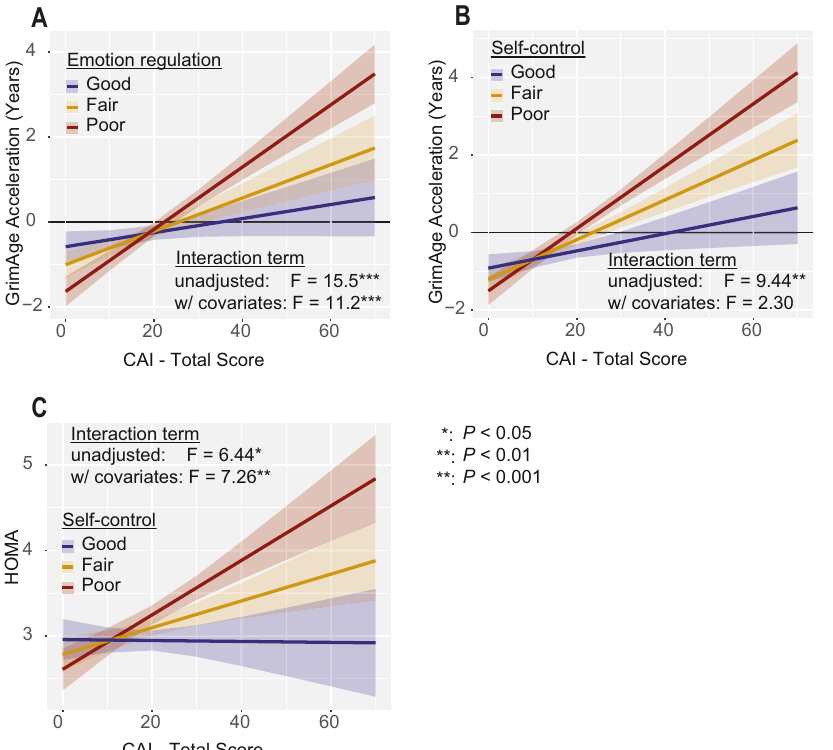
Fig. 3 Psychological resilience factors moderate the effects of cumulative stress on GrimAge Acceleration and physiologic stress pathways. A Individuals with stronger emotion regulation (as measured by lower DERS scores) suffer less GAA at high stress than individuals with poor emotion regulation before (GAA ~ CAI X DERS P = 9.51e − 5; GAA ~ CAI X DERS + Covariates: P = 8.82e − 4) and after accounting for covariates. For panel A, “ good ” represents the slope at the 25th percentile of DERS, “ fair ” at the 50th percentile, and “ poor ” the 75th percentile. B Better self-control (as measured by higher B-SCS scores) is protective against the effects of stress on GAA before accounting for covariates (GAA ~ CAI X SCS P = 0.00226; GAA ~ CAI X SCS + Covariates: P = 0.130), but not after including them in the model. C Stronger self-control moderates the relationship between stress and insulin resistance before (HOMA ~ CAI X SCS P = 0.0115; HOMA ~ CAI X SCS + Covariates P = 0.00732) and after accounting for covariates. For panels (B) and (C), “ good ” represents the slope at the 75th percentile of B-SCS, “ fair ” at the 50th percentile, and “ poor ” the 25th percentile.